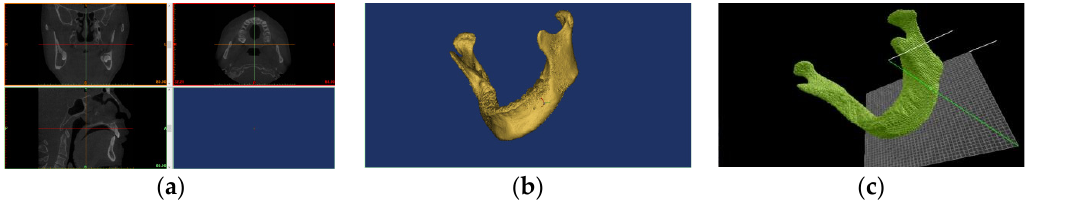
Figure 2. Voxelized 3D model construction. ( a ) Original CT image ( b ) Mandible 3D model construc- tion ( c ) 3D model voxelization.